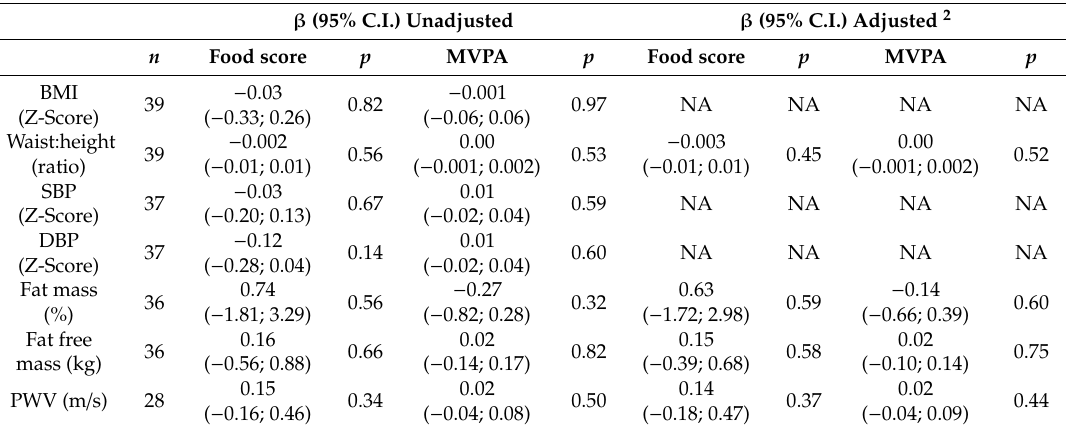
Table 4. Linear regression analysis of the preconception food score (0–5 points; the higher the more healthy) and preconception moderate to vigorous physical activity (MVPA) and o ff spring cardiovascular health at age 3–6 years 1